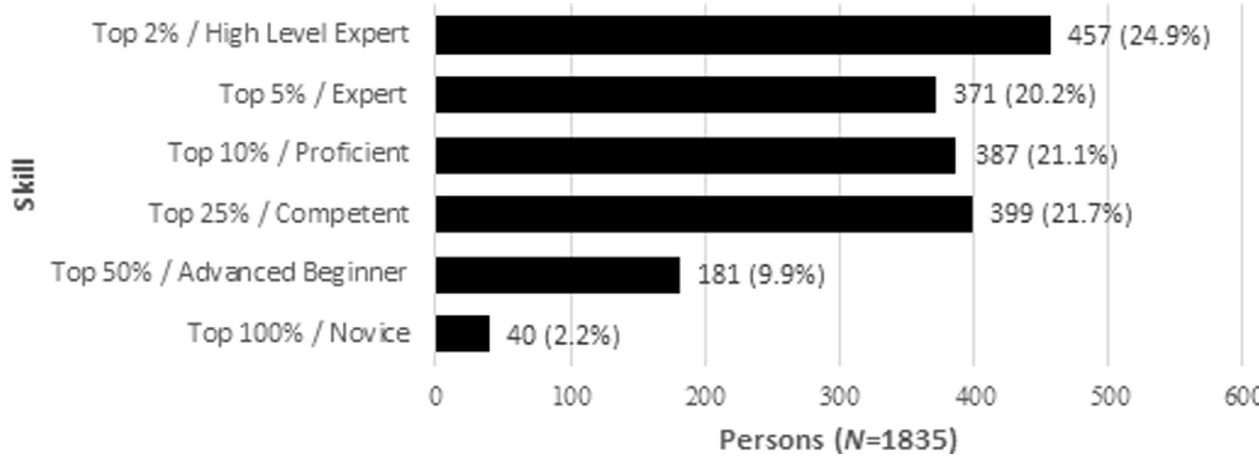
Fig 8. Skill level distribution.